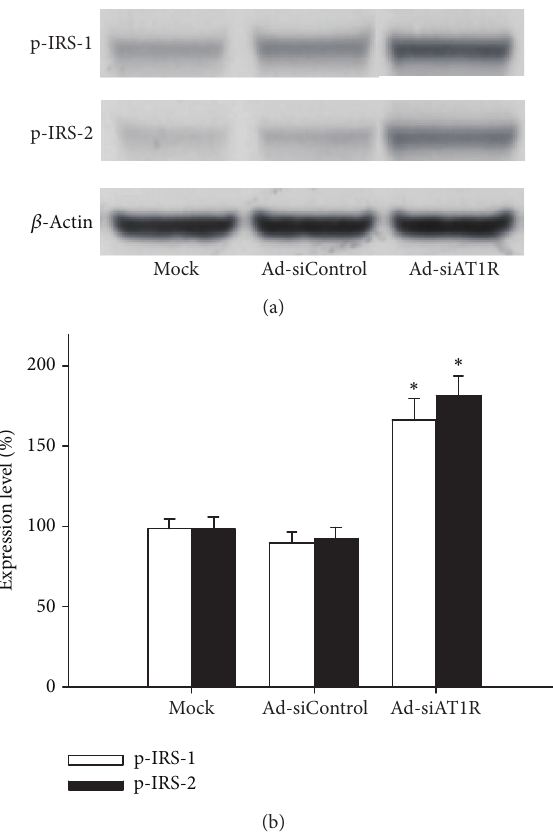
Figure 3: Effects of AT1R silencing on IRS-1 and IRS-2 expression. Isletsofdb/dbmiceweretransfectedwithAd-siAT1R,Ad-siControl, or Mock and cells were cultured for 72 h prior to quantitative immunoblot evaluation. Results are represented as mean ± SD for six independent experiments. ∗ 𝑃 < 0.05 versus